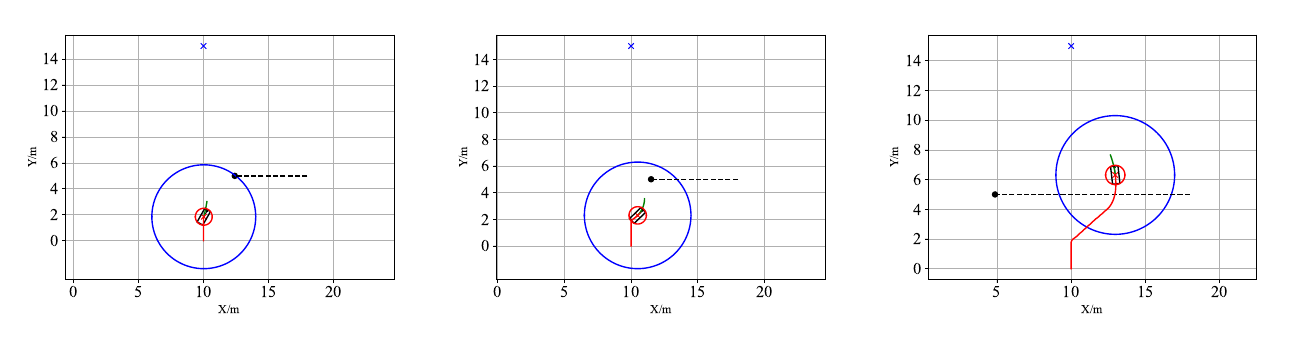
Figure 14. Crossing situation for DWA algorithms conforming to COLREGs.